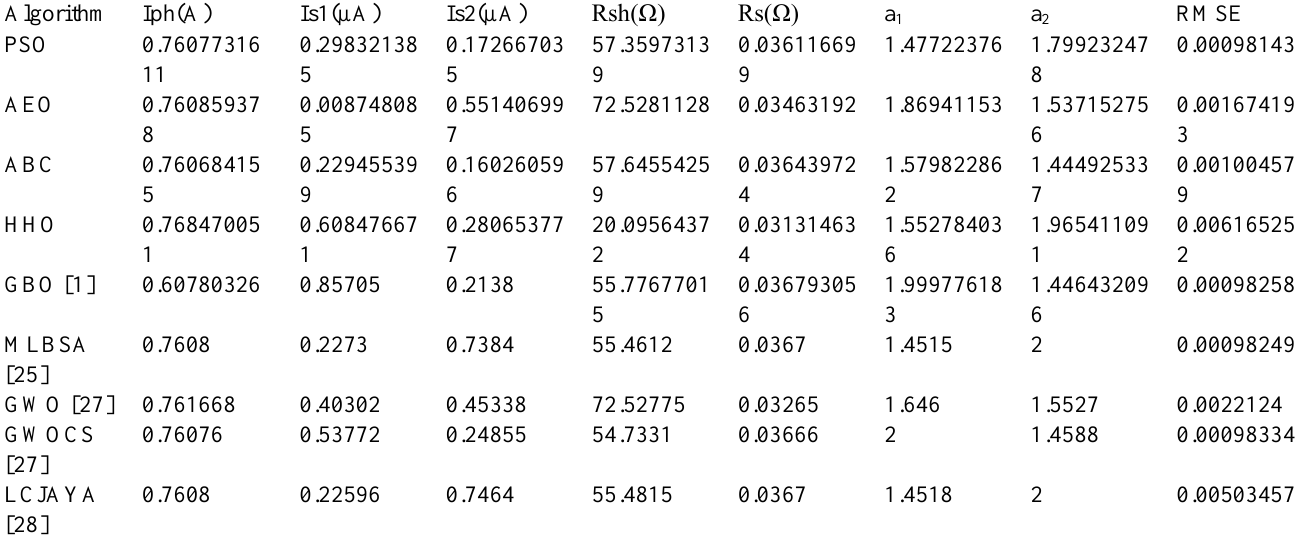
Extracted parameters for double diode model at the best root mean square error